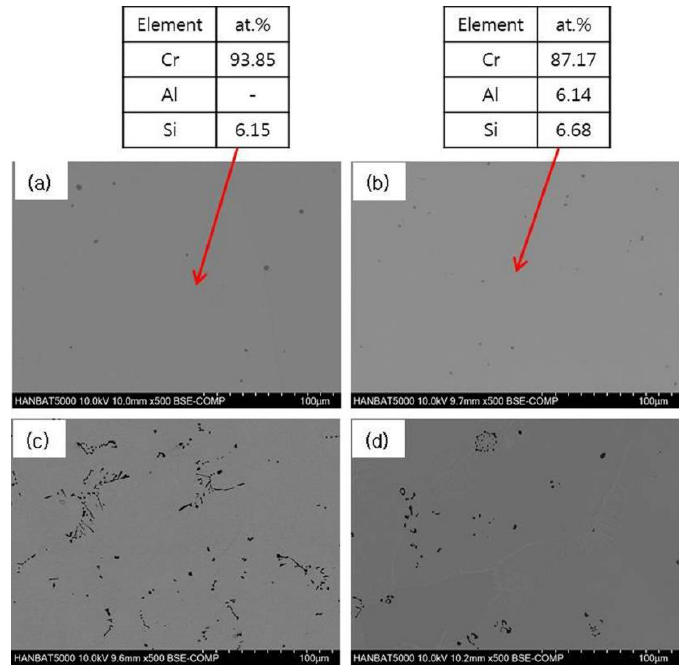
Figure 1. SEM-EDS analyses of as-cast Cr–xAl–5%Si alloys (500X): ( a ) 0% Al; ( b ) 5% Al; ( c ) 10% Al; and ( d ) 20% Al.